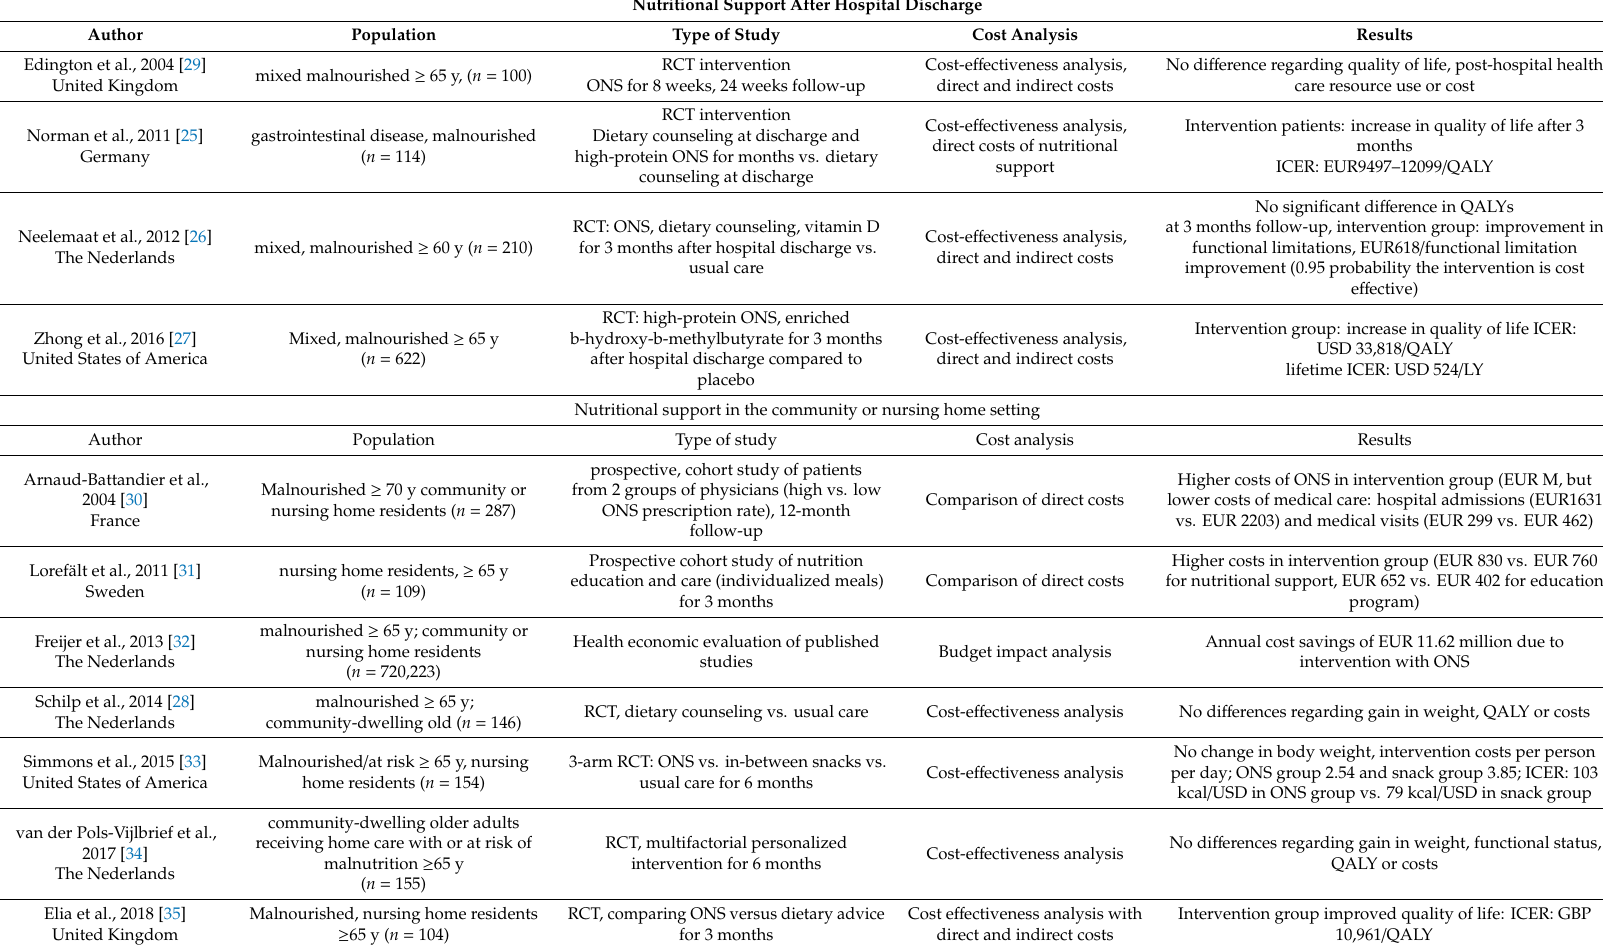
Table A5. Studies addressing the economic impact of nutritional support after hospital discharge in the community or nursing home